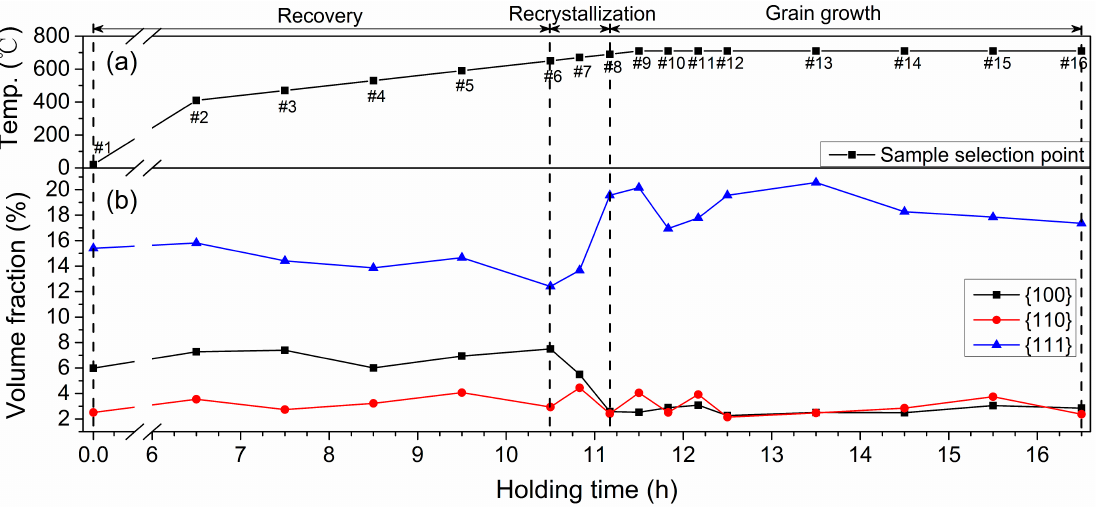
Figure 1. Samples in annealing processing: ( a ) samples with different annealing process shown in circle symbols; ( b ) texture volume fraction of the {100}, {110} and {111} texture components.